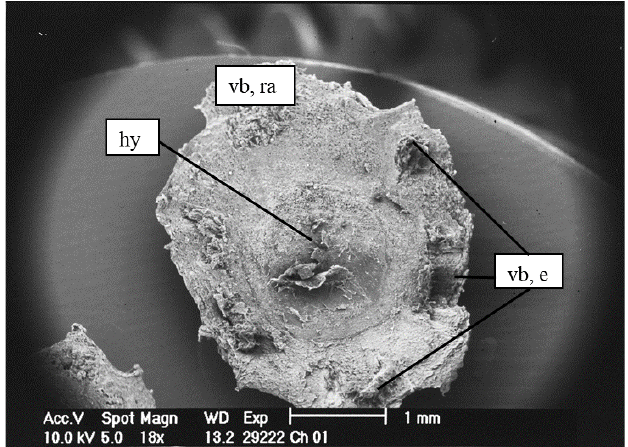
Fig. 6: SEM image of the chalaza from inside. hy = hypostasis, vb ra = vascular bundle from the raphe, vb e = vascular bundle entering the endotesta, magnification: see scale.